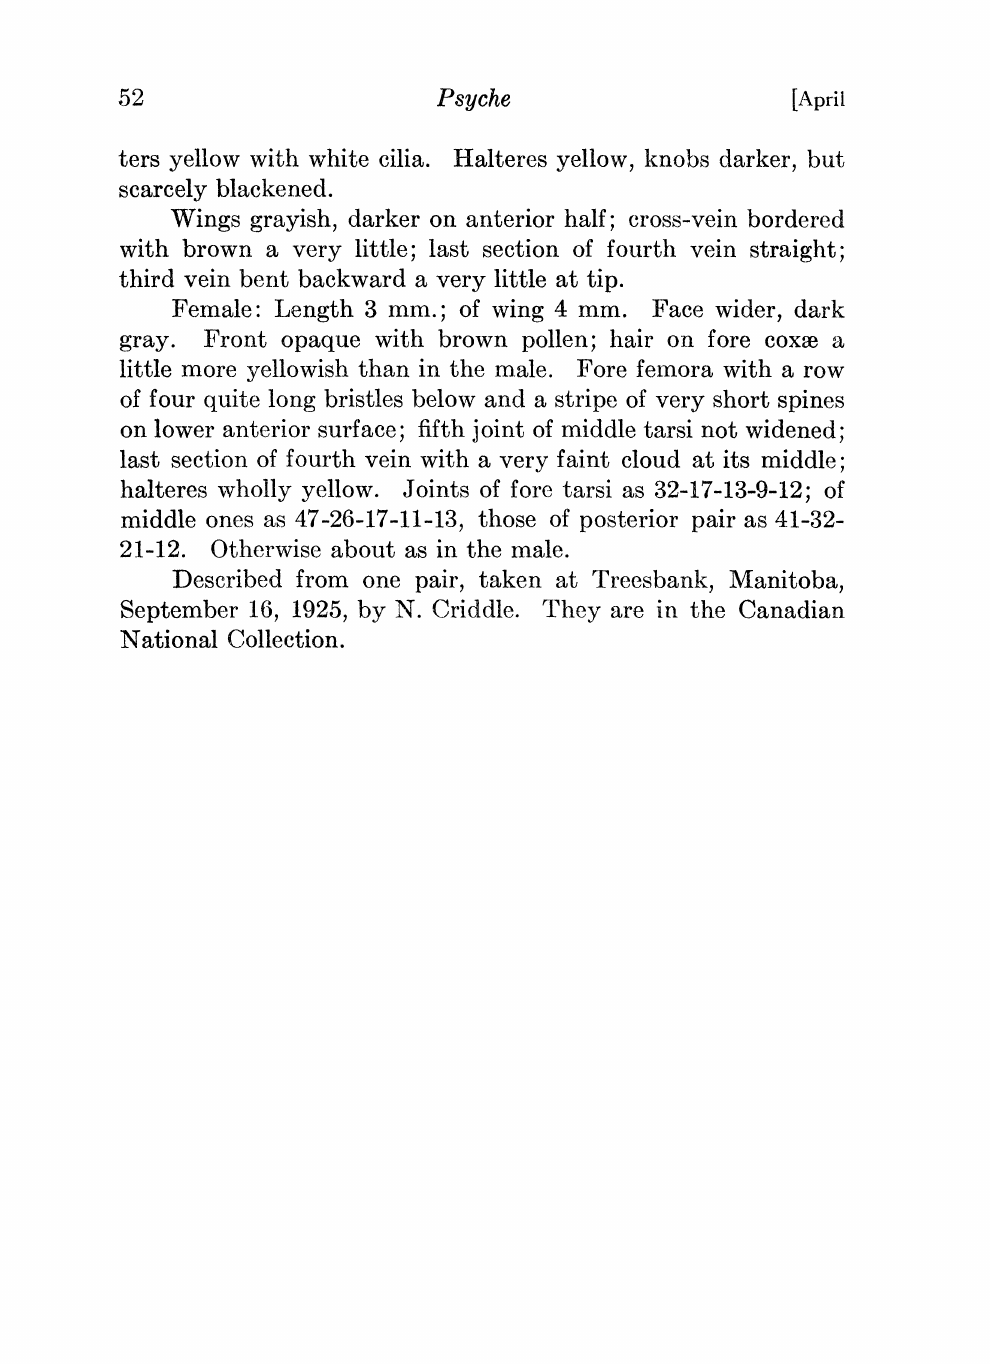
ters yellow with white cilia. Halteres yellow, knobs darker, but scarcely